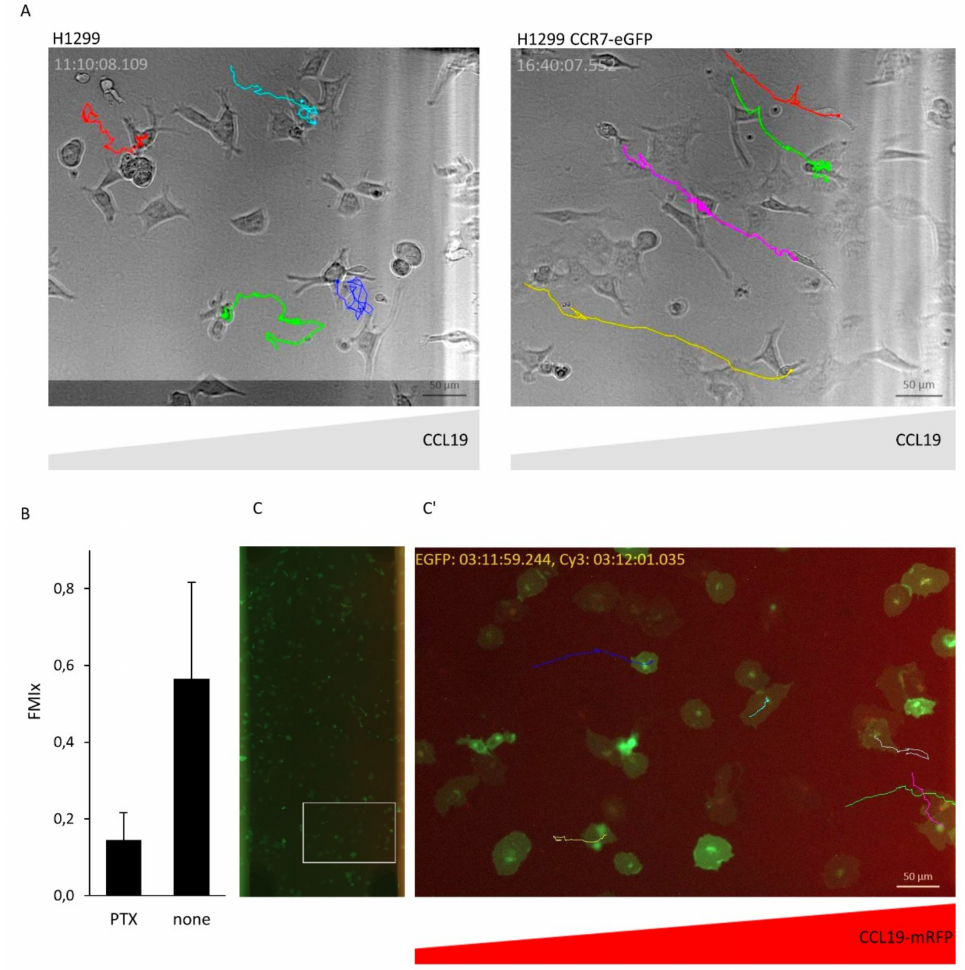
Figure 6. CCR7-dependet migration of H1299 cancer cells along CCL19 and CCL19-mRFP gradients. ( A ) H1299 wild-type cells and H1299 cells expressing CCR7-eGFP were imbedded in 3D collagen